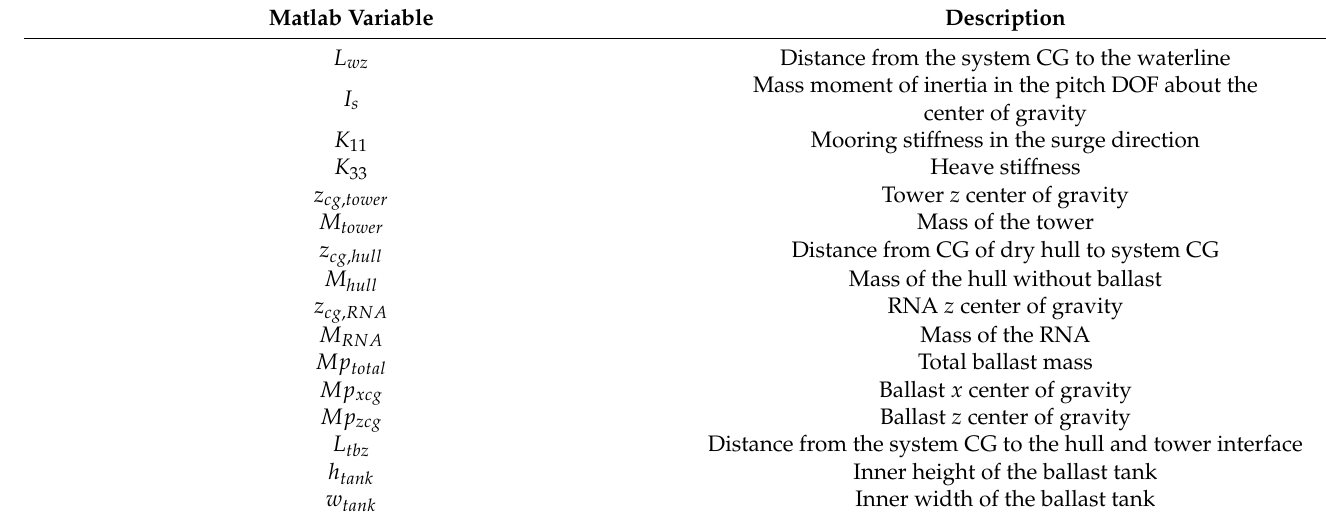
Table 3. Frequency domain inputs.